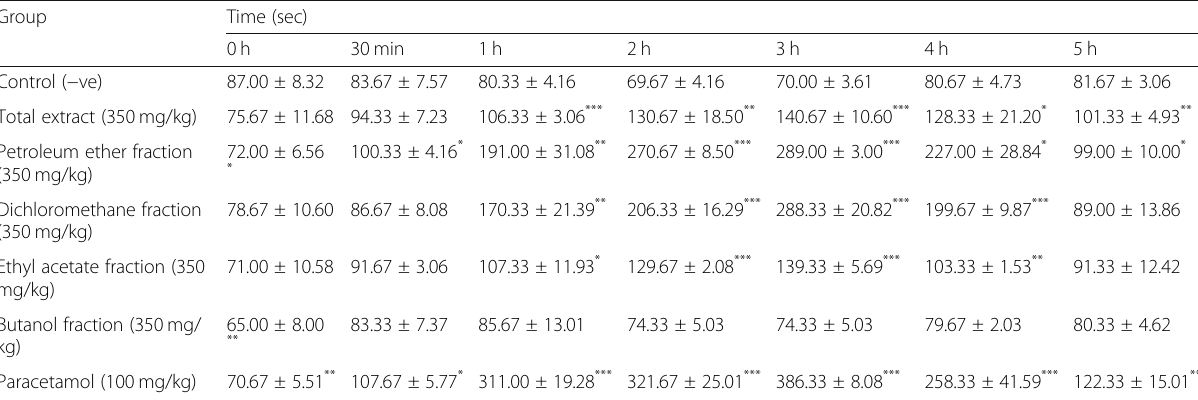
Table 7 Results of the analgesic activity of the total ethanol extract and the different fractions of C. myxa L. leaves in mice using the hot plate method using paracetamol as a standard Group